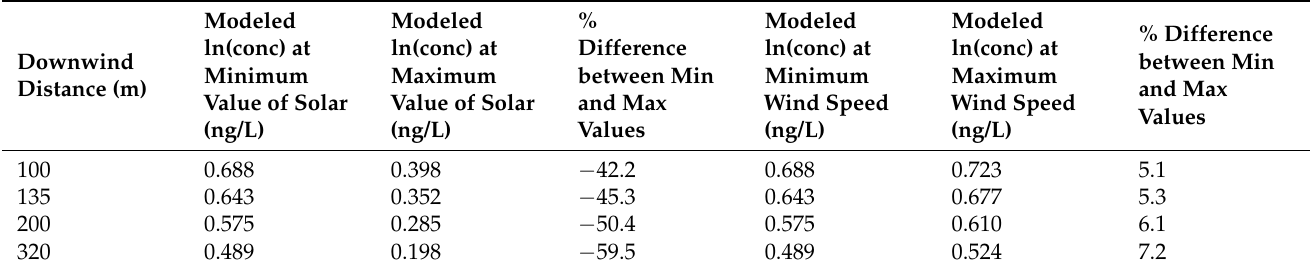
Table 3. Modeled ln (concentration) at minimum and maximum values of variables wind speed and solar radiation for Weather Method 2. Value of the other variable was held to minimum value to illustrate the effect of changes in the variable of